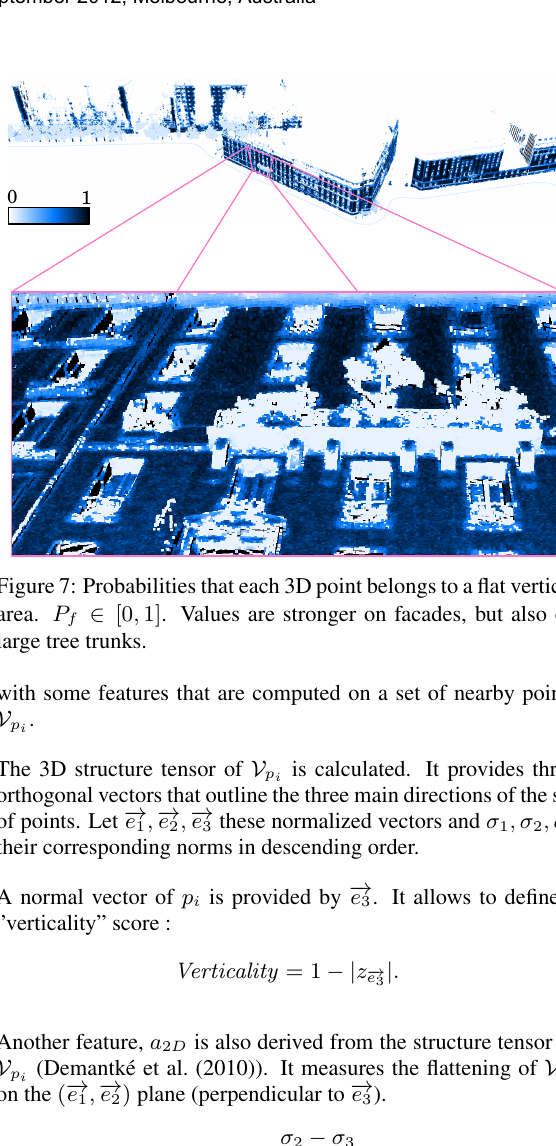
Figure 5: Line segment soup (colored rectangles).